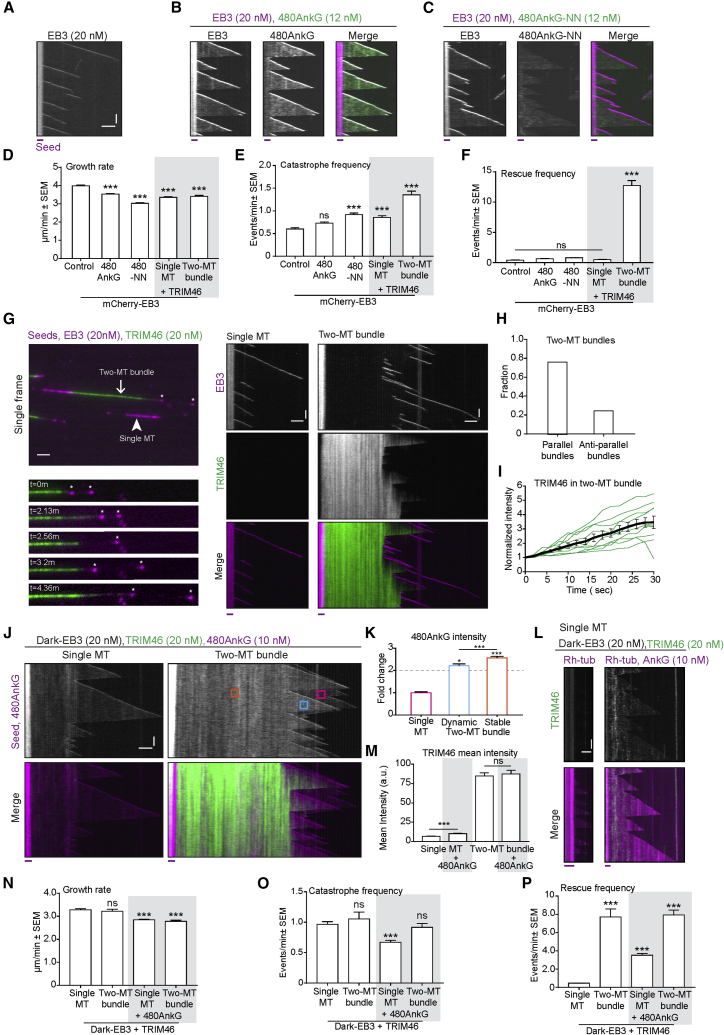
TRIM46 Promotes Rescues within Parallel MT Bundles and Shows Weak Interaction with 480AnkG In Vitro(A–C) Kymographs showing MTs dynamics grown in the presence of mCherry-EB3 alone (A) or together with 480AnkG-GFP (B) or 480AnkG-NN-GFP (C).(D–F) Quantification of MT plus-end growth rate (D), catastrophe frequency (E) and rescue frequency (F) in the presence of mCherry-EB3 (n = 213) together with 480AnkG-GFP (n = 388), 480AnkG-NN-GFP (n = 458), or GFP-TRIM46 (n = 235 for single MTs and n = 91 for two-MT bundles), 2–3 assays per condition. One-way ANOVA with Tukey’s multiple comparisons test, ns p > 0.05, ∗∗∗p < 0.001.(G–I) (G) Left panels: single frame (top) of a time-lapse video showing single MT (arrowhead) and two-MT bundle (arrow) growing from rhodamine-tubulin-labeled GMPCPP seeds in the presence of mCherry-EB3 and GFP-TRIM46 and still pictures (bottom) at indicated time points (in min). Corresponding kymographs are shown in the middle panel. (H) Fraction of parallel and anti-parallel TRIM46-decorated two-MT bundles (n = 41 bundles). (I) Average intensity (±SEM, black) of GFP-TRIM46 over time in two-MT bundles, normalized to its intensity at the time when bundles form (n = 10 events in green, from 7 TRIM46-positive two-MT bundles, three assays per condition).(J and K) Kymographs (J) showing 480AnkG-mCherry dynamics of single MTs or TRIM46 MT bundles in the presence of dark-EB3. 480AnkG-mCherry mean intensity (K) on single MTs (magenta) or two-MT TRIM46-bundles (dynamic, cyan; stable, orange) normalized to average mean intensity on single MTs, from 1 μm2 33–76 regions of interest (ROIs) of 7–15 TRIM46-decorated two-MT bundles from 6–8 assays. Error bars show 95% confidence interval. One sample t test was carried out to test whether fold change in AnkG intensity on TRIM46-bundles is more than 2, ∗p < 0.05, ∗∗∗p < 0.001. One-way ANOVA was used to test whether the change in 480AnkG intensity was different in dynamic compared to stable two-MT bundle, ∗∗p = 0.0050.(L) Kymographs illustrating GFP-TRIM46 fluorescence intensity on single MTs grown in the presence of dark-EB3, 14.5 μM porcine tubulin, and 0.5 μM rhodamine-tubulin without (left) or with 480AnkG-mCherry (right).(M) Mean intensity of GFP-TRIM46 on single MTs or TRIM46- bundles with or without 480AnkG-mCherry, from 1 μm2 80–140 ROIs from 8–14 single MTs or TRIM46 two-MT bundles, 3 assays per condition. Error bars are SEM. Two-tailed unpaired t test, ns p > 0.05, ∗∗∗p < 0.001.(N–P) Quantification of MT plus-end growth rate (N), catastrophe frequency (O), and rescue frequency (P) in the presence of dark-EB3 and GFP-TRIM46 together with 480AnkG-mCherry and 15 μM porcine tubulin or 14.5 μM porcine tubulin and 0.5 μM rhodamine-tubulin. n = 139 and n = 188 single MTs without or with 480AnkG, respectively, and n = 26 and n = 87 TRIM46-decorated MT bundles without or with 480AnkG, respectively, 2–3 assays per condition. One-way ANOVA, ns p > 0.05, ∗∗∗p < 0.001.Scale bars in all the kymographs represent 2 μm (horizontal) and 60 s (vertical). The red line below each kymograph represents rhodamine-labeled GMPCPP-stabilized MT seeds. See also Figure S5 and Table S1.